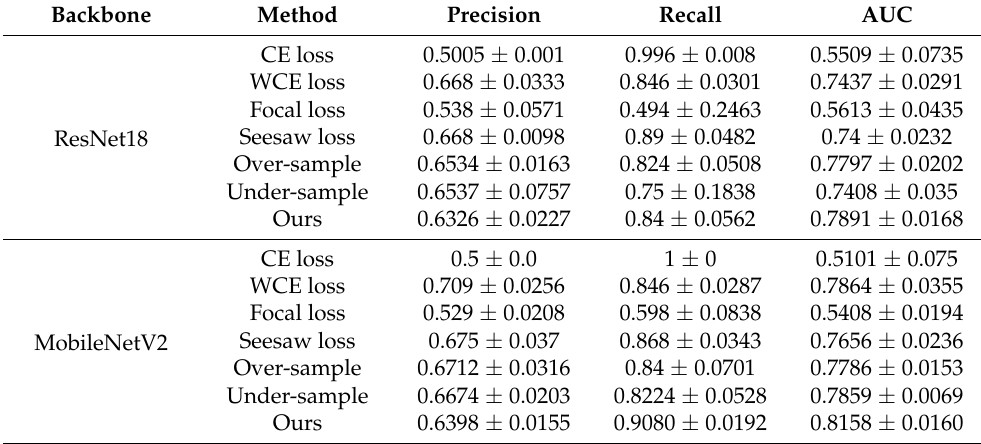
Table 2. The quantification results of different methods towards class-imbalance